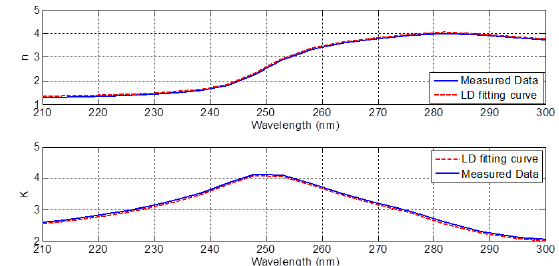
Figure 13. Experimental [12] and fitted Lorentz-Drude model for the real and imaginary parts of the GaAs refractive index in the second sub-